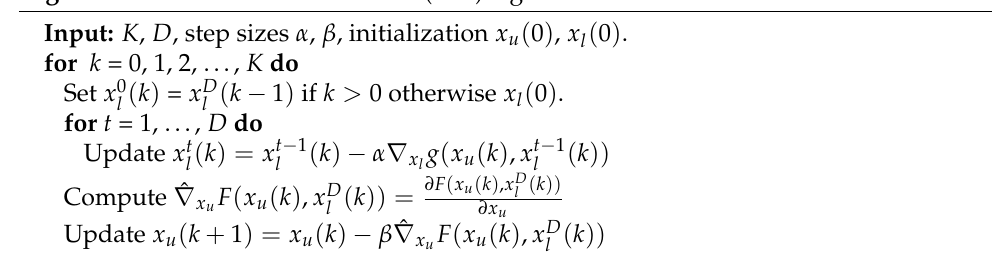
Algorithm 1 Iterative differentiation (ITD)